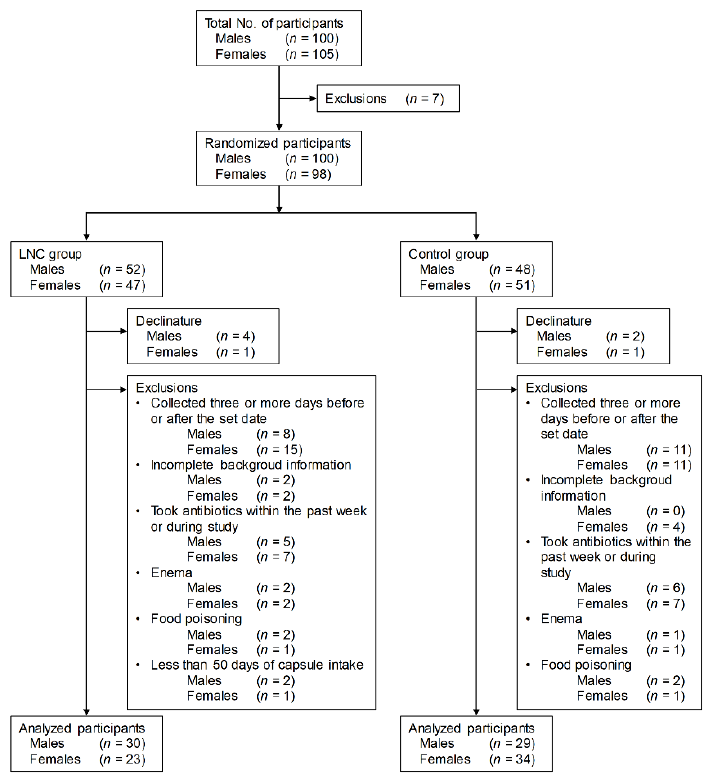
Figure 1. Screening of participants for inclusion in the study. LNC, lyophilized natto capsules. The final analysis included 30 males and 23 females in the LNC group and 29 males and 34 females in the control group.